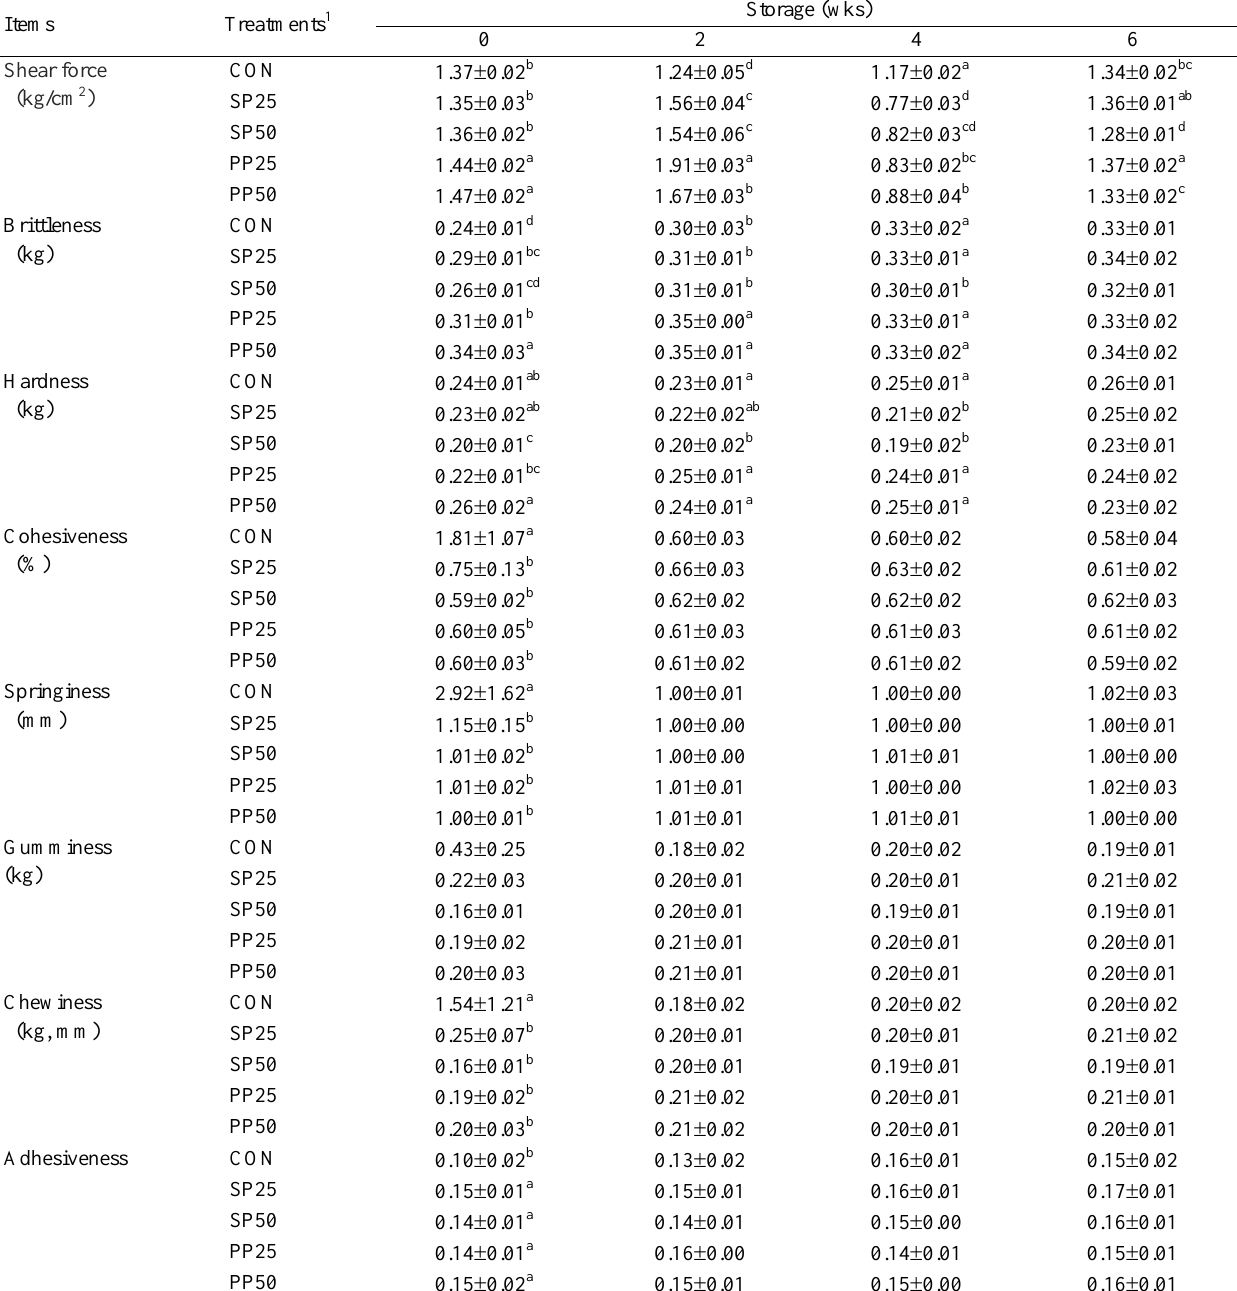
Table 5. Shear force and texture properties of cooked pork sausages containing two different percentages of purple sweet potato combined with nitrite during 6 wks of storage at 4 